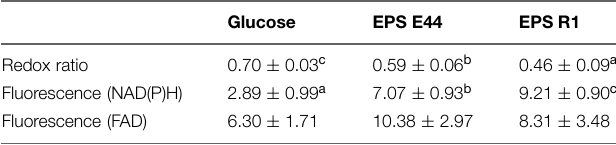
TABLE 3 | Intracellular redox ratios of NAD(P)H- and FAD fluorescence associated with B. fragilis grown in the presence of additional glucose, EPS E44 and EPS